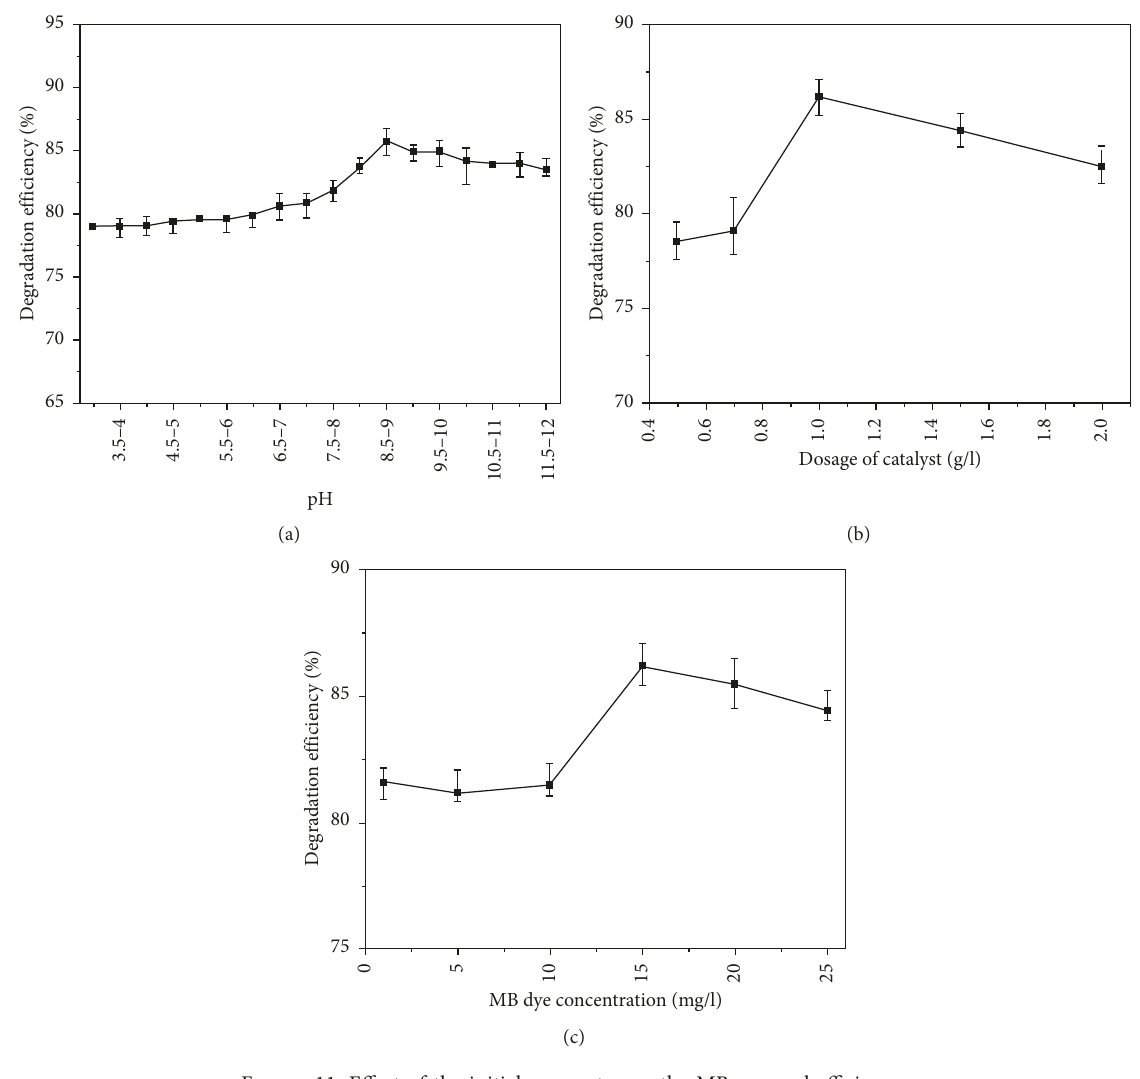
Figure 11: Effect of the initial parameter on the MB removal efficiency.